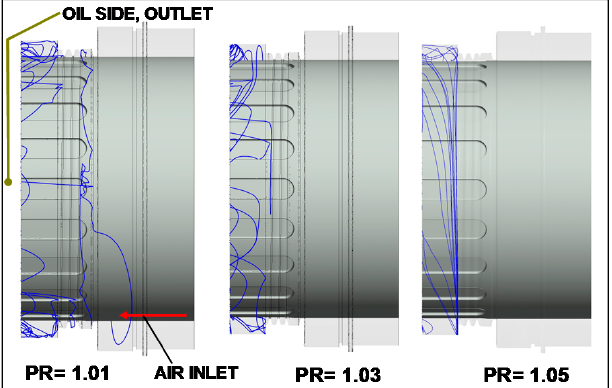
Figure 17. Oil particles trajectories at 15,000 rpm, three different pressure ratios and s = 0.3 mm.